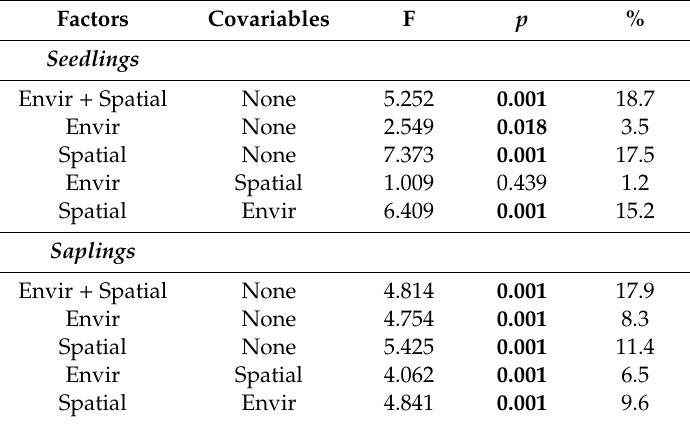
Table 5. Amount of variation of tree species compositions explained by environmental and spatial factors in di ff erent RDA variants in the old-growth forest Sitno.